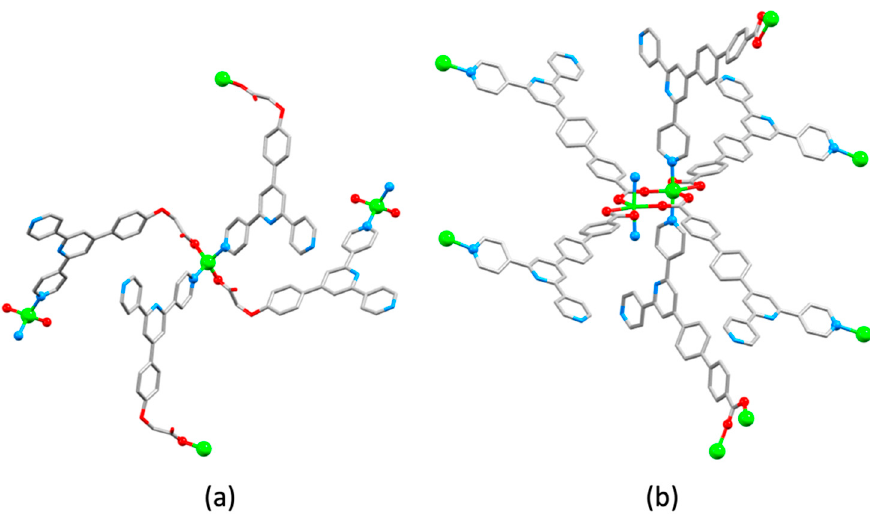
Figure 22. ( a ) Coordination environment of Zn(II) in [Zn( 32 ) 2 ] n which leads to the metal center being a 4-connecting node in a dia net (CSD refcode ZIDREL). ( b ) Coordination environment around the 8-connecting node in [Zn( 33 ) 2 ] n (refcode TEZJOA); for clarity, two of the eight ligand-linkers are represented only with the coordinated nitrogen atom.